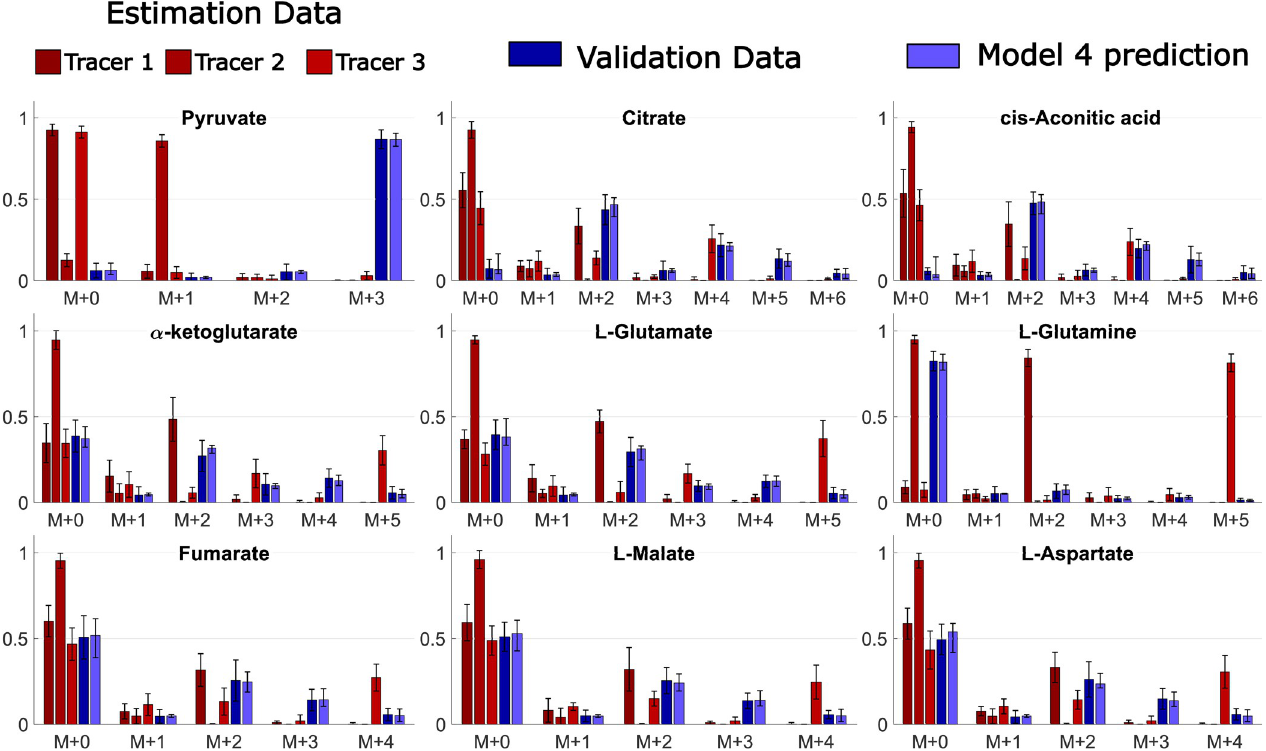
Fig 11. Usage of prediction uncertainty to demonstrate that the validation data has neither too little, nor too much, novelty, compared to the estimation data. This analysis shows the result from the simulated 13 C MFA example (Fig 7–9). The model was trained on estimation data corresponding to three tracers: Tracer 1 = 1,2- 13 C-glutamine (dark red), Tracer 2 = 3- 13 C-pyruvate (red), and Tracer 3 = U- 13 C-glutamine (light red). The validation data (dark blue) came from usage of tracer U- 13 C-pyruvate. For the experimental data, the error bars represent standard deviation, and for the model predictions (light blue), the error bars represent model uncertainty (Section